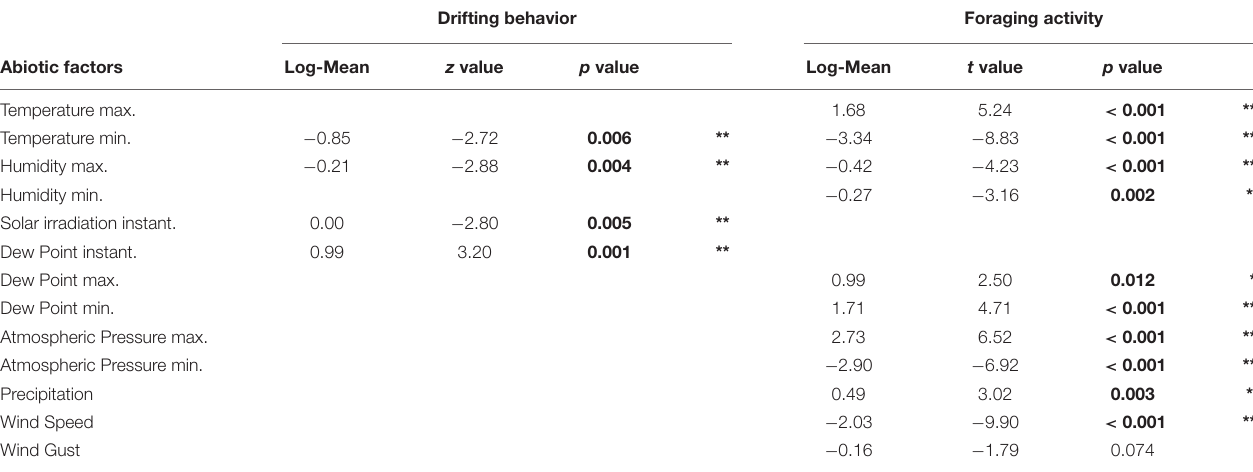
TABLE 1 | Abiotic factors affecting both drifting behavior and foraging activity. Drifting behavior Foraging activity Abiotic